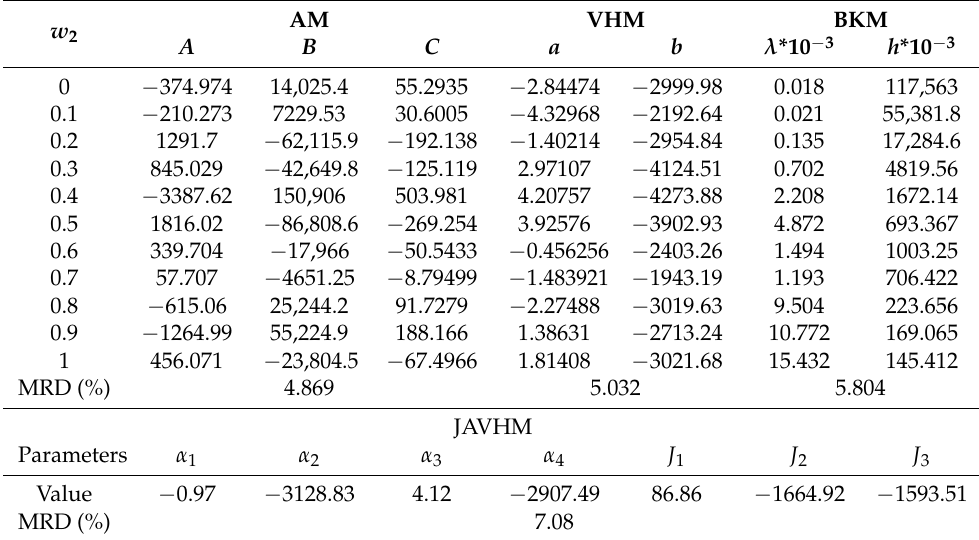
Table 2. Parameters of the modified AM equation, VHM equation, BKM equation and